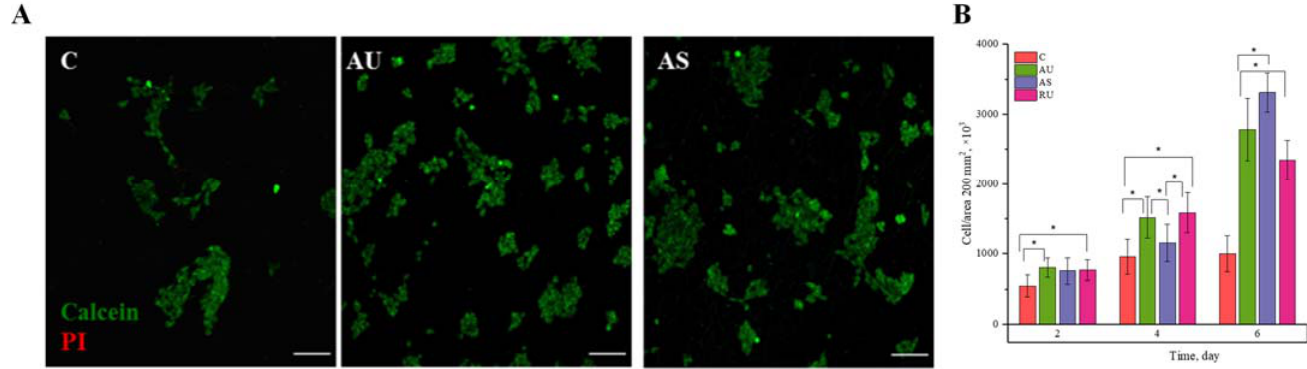
Figure 2. In vitro study of biocompatibility of the experimental scaffolds. ( A ) Representative confocal images of IMR ‐ 32 cell viability when cultured on AU and AS fibers for 3 days. Coloring: green–calcein ‐ AM, red–PI. Scale bar—100 μ m. ( B ) Proliferation of IMR ‐ 32 cells at different times of cultivation. Results from five independent experiments each. C denotes a poly ‐ D ‐ lysine ‐ coated slide used as a control. * Statistically significant difference, p < 0.05.